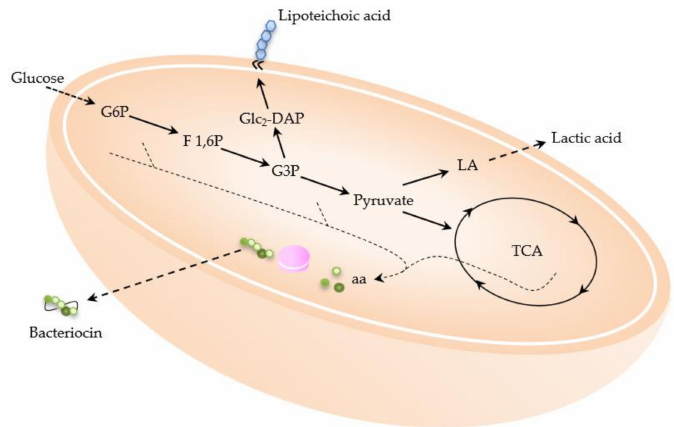
Figure 2. Illustration of the co-production of compounds in lactic acid bacteria (LAB). Extracellular products such as lactic acid (LA) and bacteriocins are synthetized and excreted from the cell, whereas lipoteichoic acid (LTA) accumulates in the cell walls of the